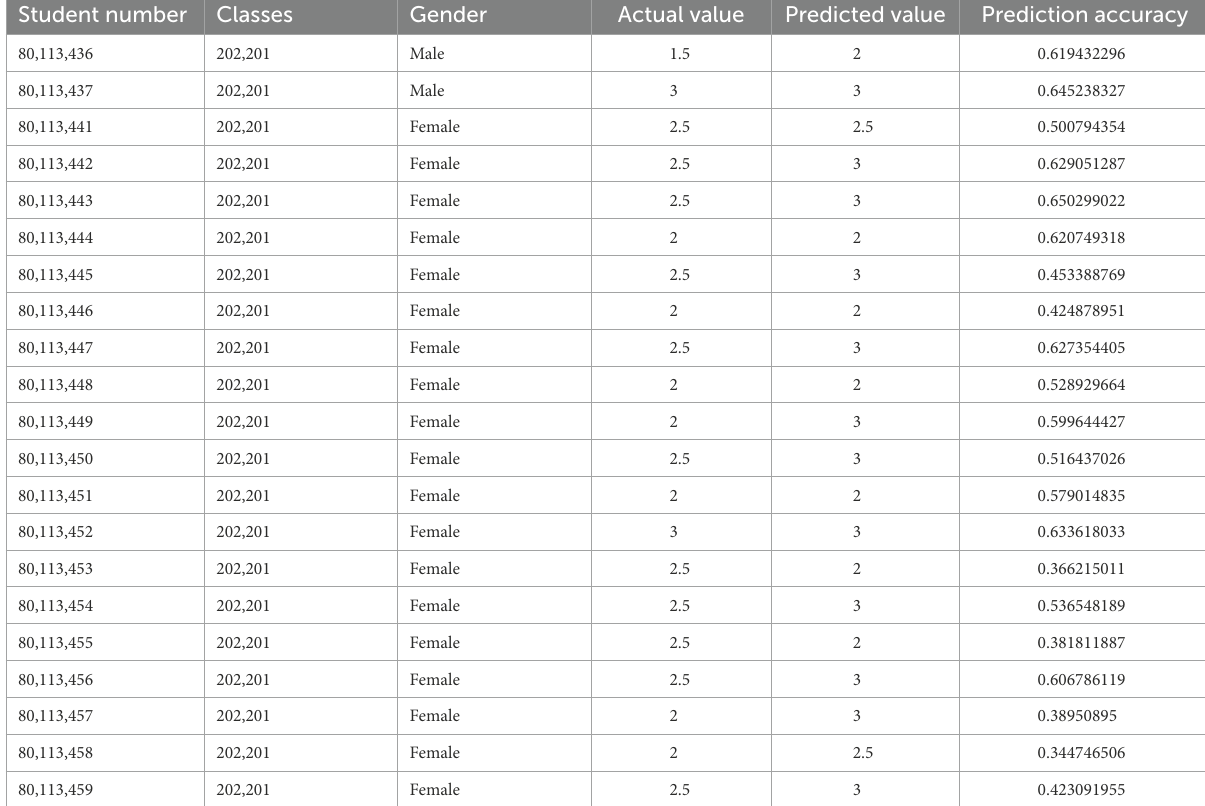
TABLE 4 Partial results for the prediction table for normal_2022 (under sophomore